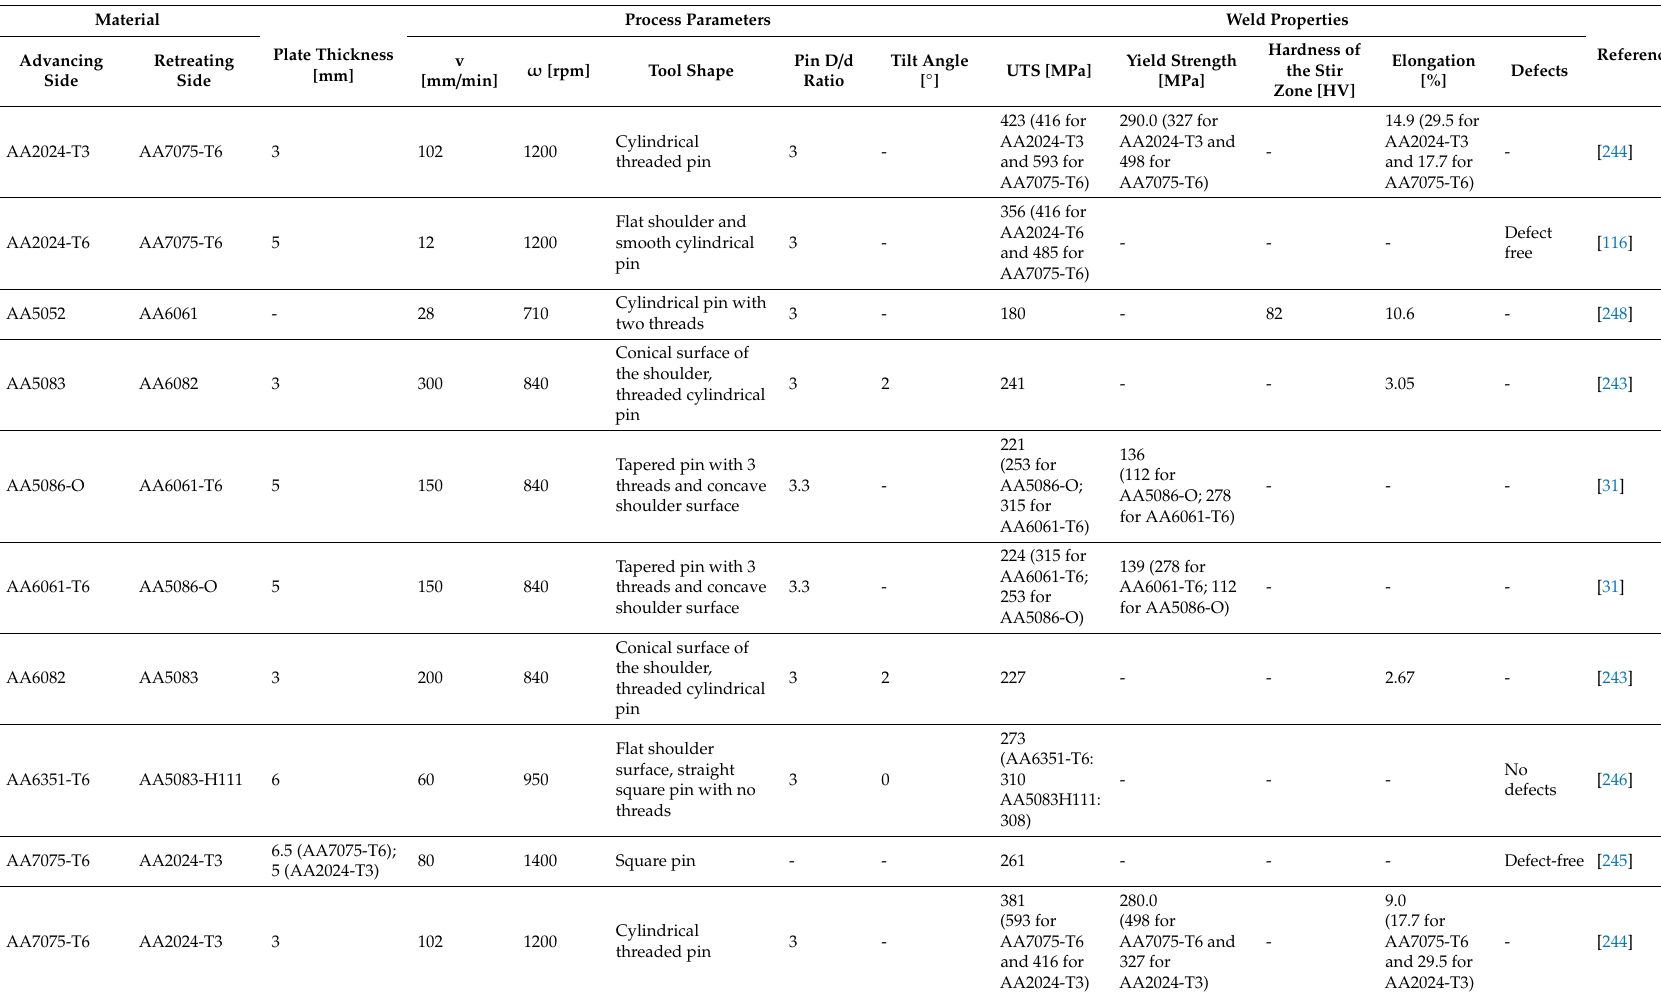
Table 8. FSW of dissimilar materials—process parameters and mechanical properties of the